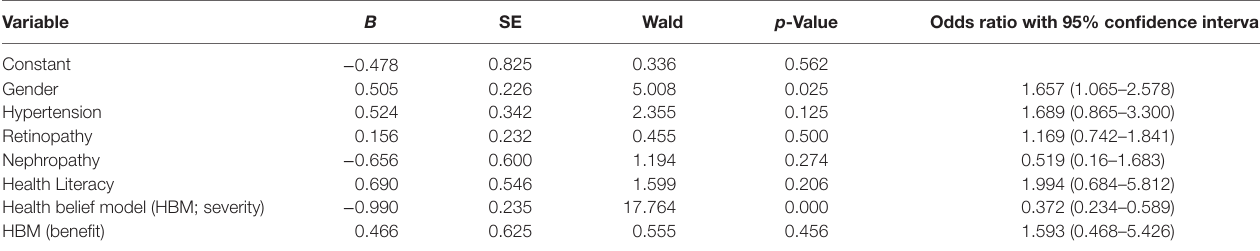
Table 4 | logistic regression model for independent variables to predict adherence.